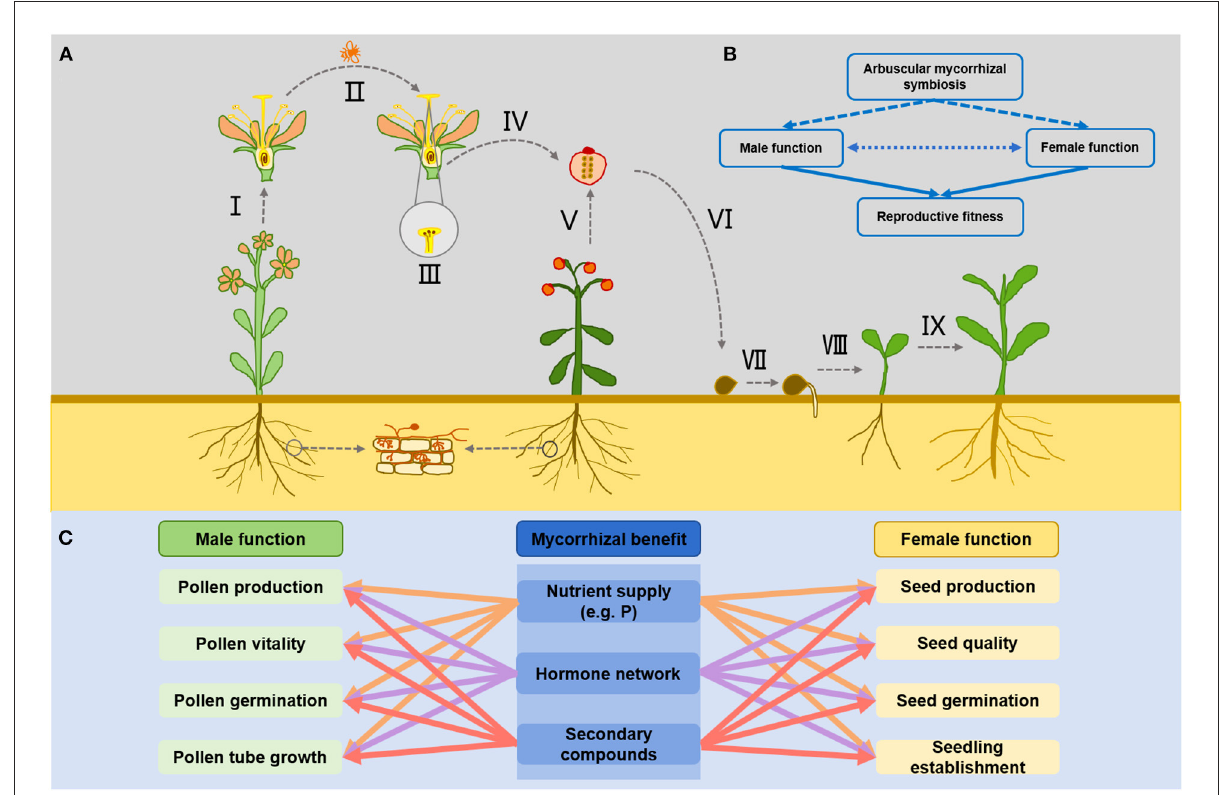
FIGURE1 Effects of AM symbiosis on the reproductive function of host plants. (A) Represents the way in which AM symbiosis may participate in the realization of male and female functions during plant reproduction, and I represents the pollen production; II represents that changes in floral characteristics may potentially affect pollinators pollination behavior; III represents the pollen germination and pollen tube growth on stigma; IV represents the fruit formation and seed development after successful fertilization; V represents the seeds production; VI represents the seeds quality; VII represents the seeds germination; VIII represents the successful establishment of seedlings after germination; IX represents the growth of offspring seedlings. (B) Simplifies the AM symbiosis effects on plant reproduction fitness. AM symbiosis may directly and indirectly affect the male and female functions of plants through nutrient supply and hormone regulation, thus affecting their reproductive fitness. The Mutual adaptation and coordinate between male and female function may also be affected by the AM symbiosis, thus affecting the reproductive fitness of mycorrhizal plants. (C) Indicates that AM symbiosis may directly or indirectly regulate the reproductive function of plants through nutrient supply (phosphorus and other essential elements), regulation of hormone network and synthesis of secondary compounds (such as amino acids, proteins, terpenoids, and flavonoids) during the realization of male and female functional fitness of